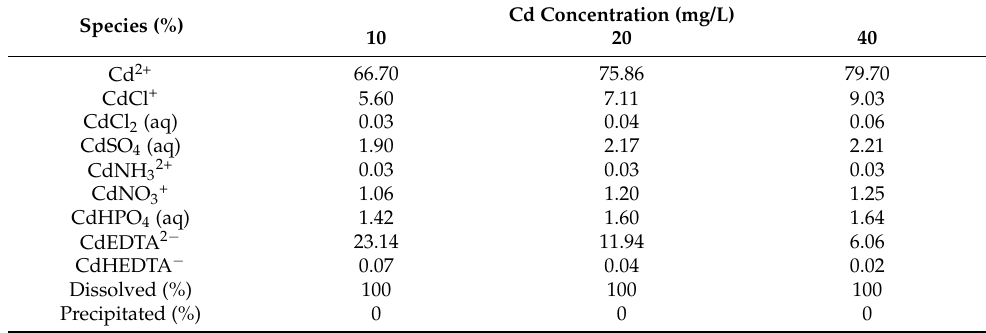
Table 1. Cd speciation in 0.2 × MS medium at pH 5.7 predicted by Visual MINTEQ 3.1. Species